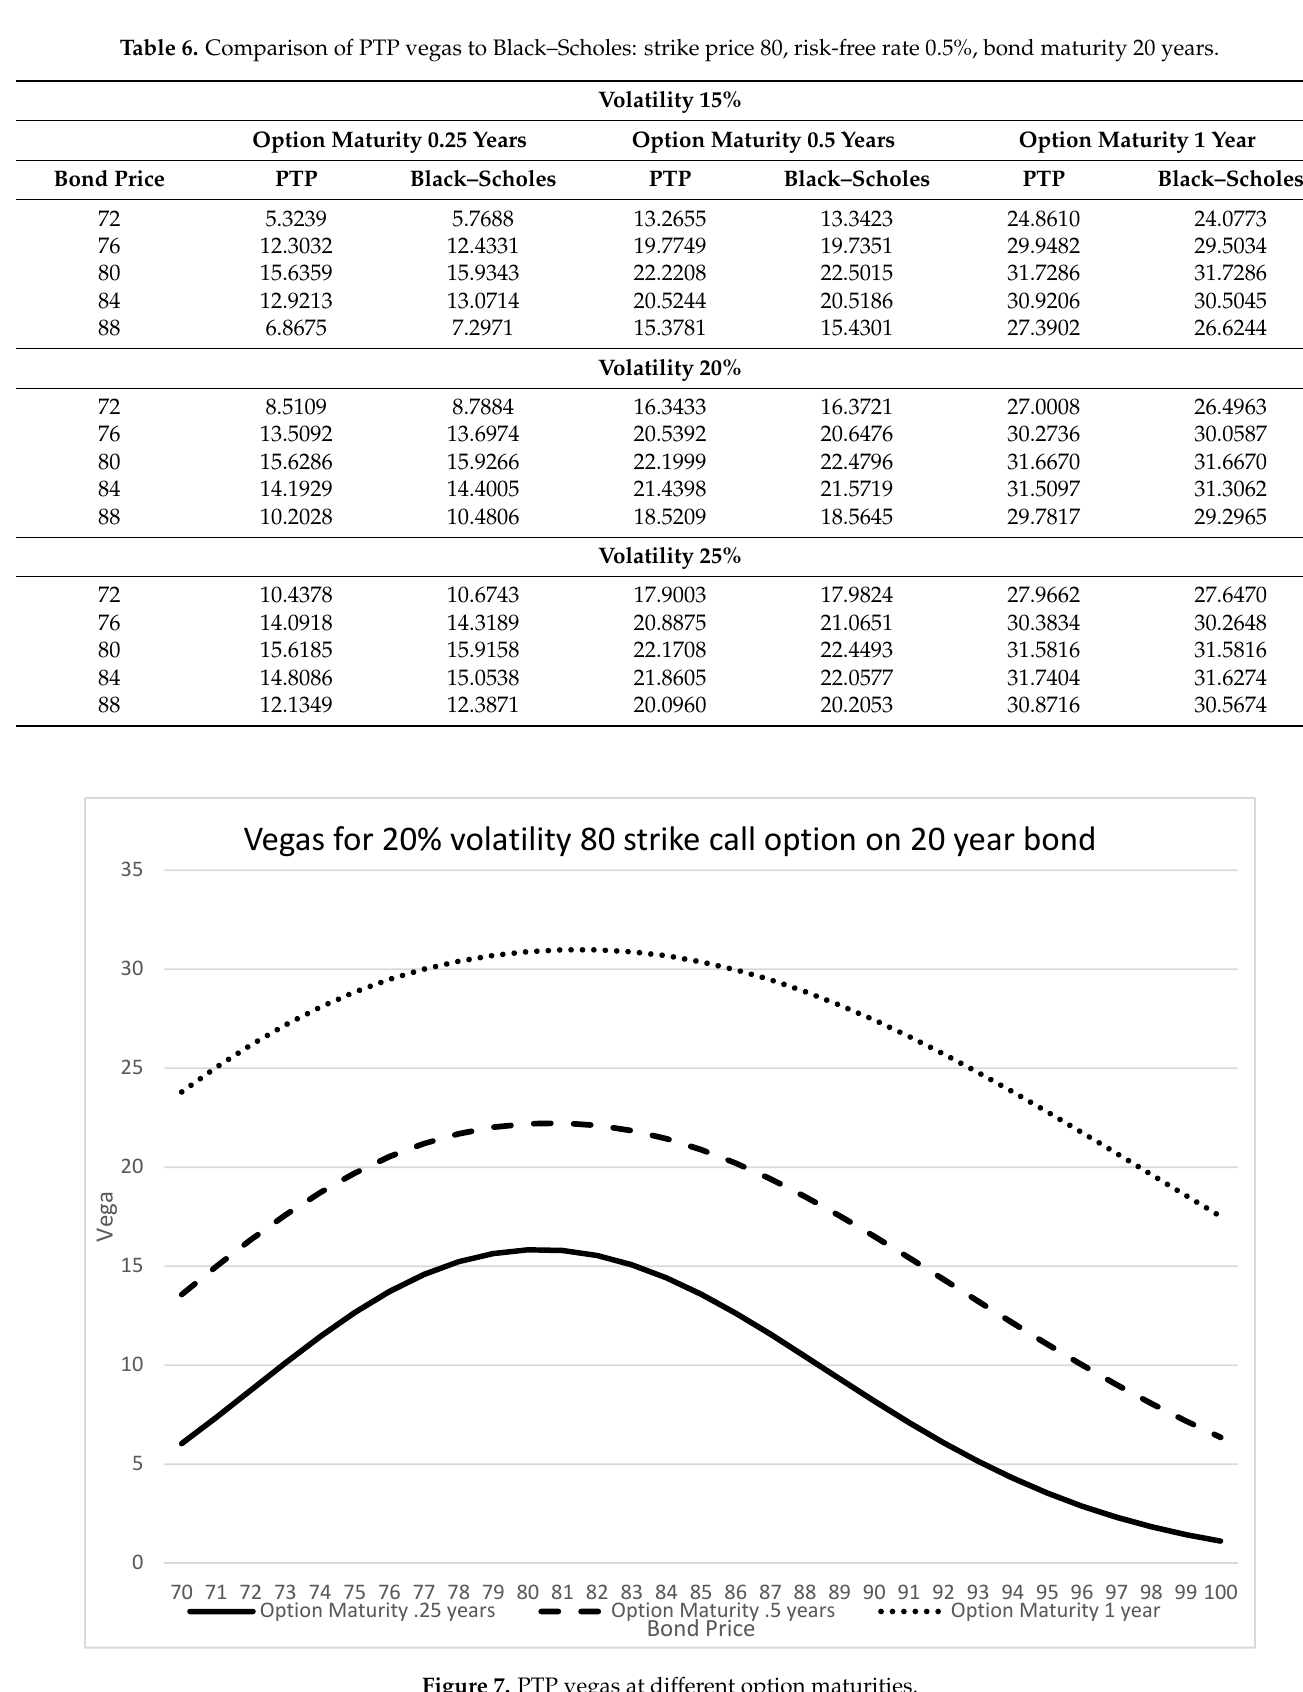
Figure 7. PTP vegas at different option maturities.